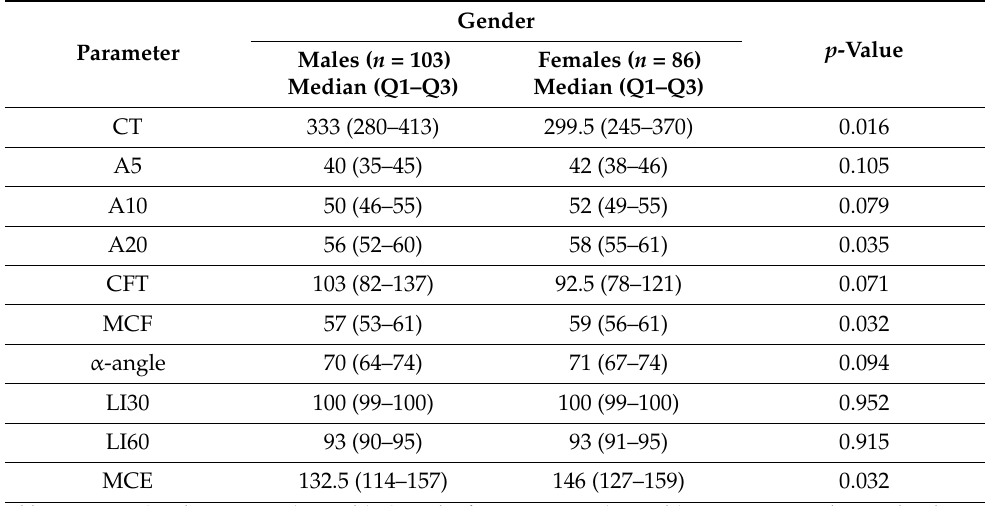
Table 3. NATEM parameters and gender of